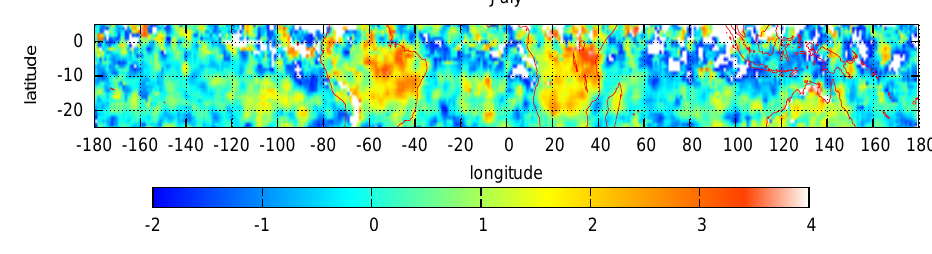
Fig. 13. Daily Tropospheric Excess (ppmv) in July retrieved from satellite measurements by Ch´edin et al. (2003).